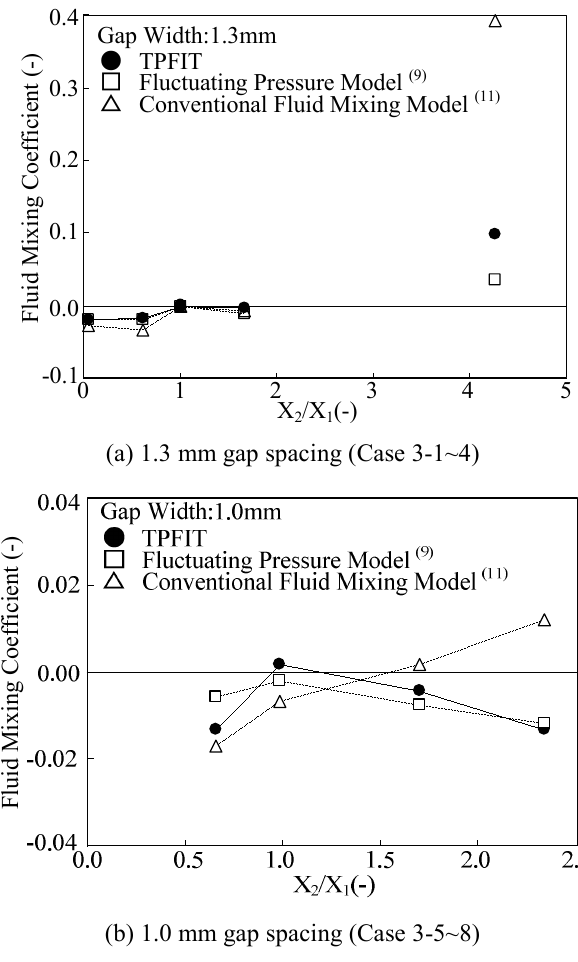
Fig.10 Evaluation of the existing correlations for FLWR cases (Case